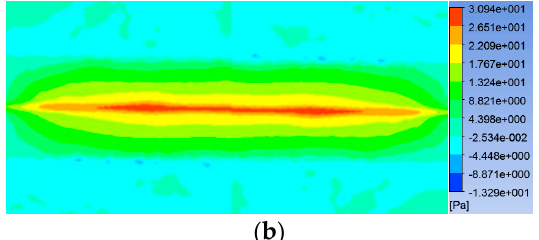
Figure 7. Strip pressure distribution above and under the strip. ( a ) Above the strip; ( b ) under the strip.